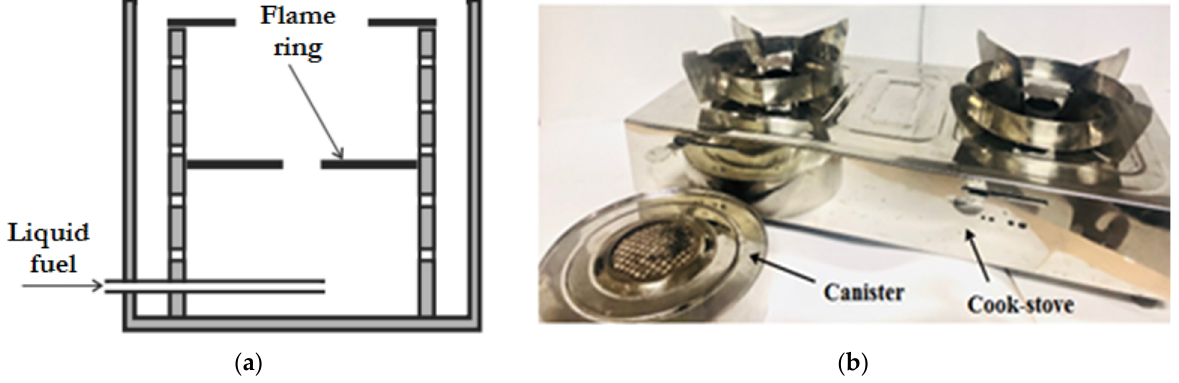
Figure 7. Schematic of vaporizing type ( a ) burner and ( b ) cook-stove.